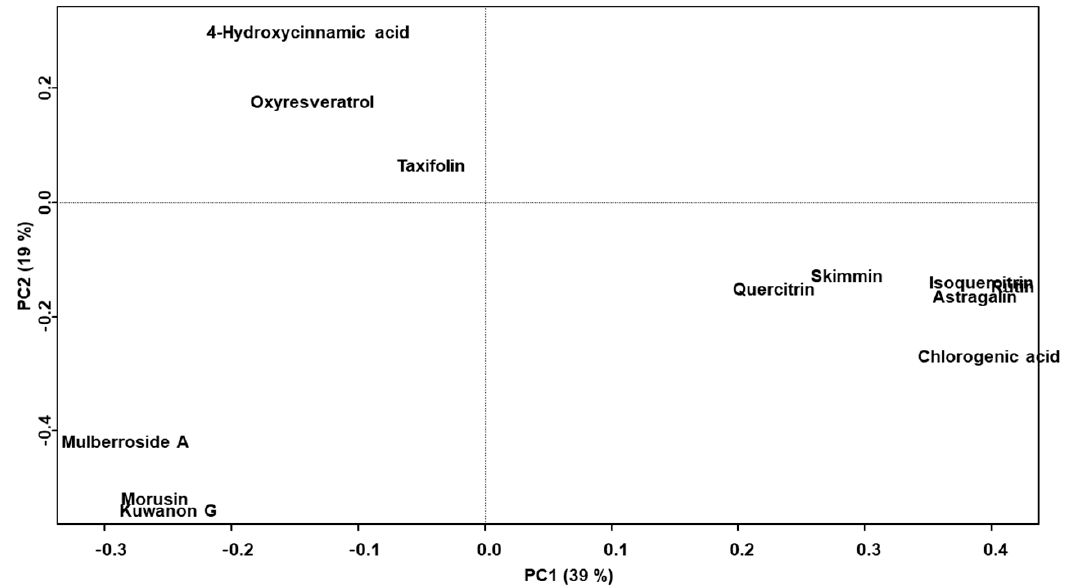
Figure 5. The principal component loading plot (PC1 vs. PC2) from the 12 marker compound contents of the Morus samples. PC1 and PC2 contributed to 39% and 19% of the total variance, respectively.